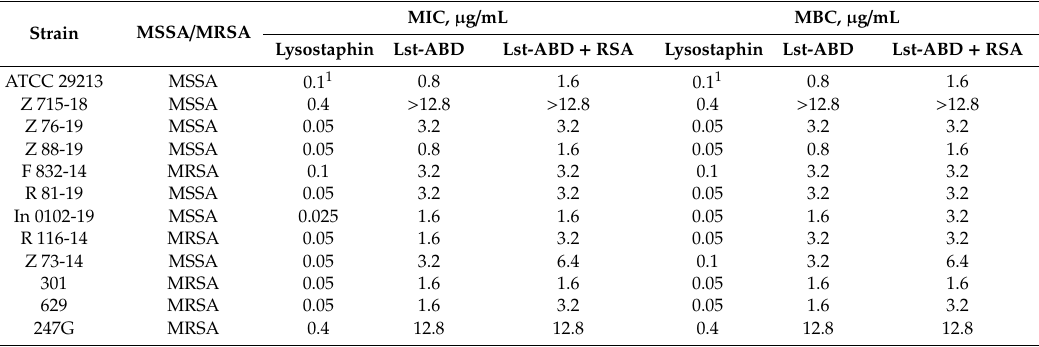
Table 2. Minimum inhibitory concentration (MIC) and minimum bactericidal concentration (MBC) values of lysostaphin, Lst-ABD, and Lst-ABD in the presence of RSA against di ff erent Staphylococcus aureus